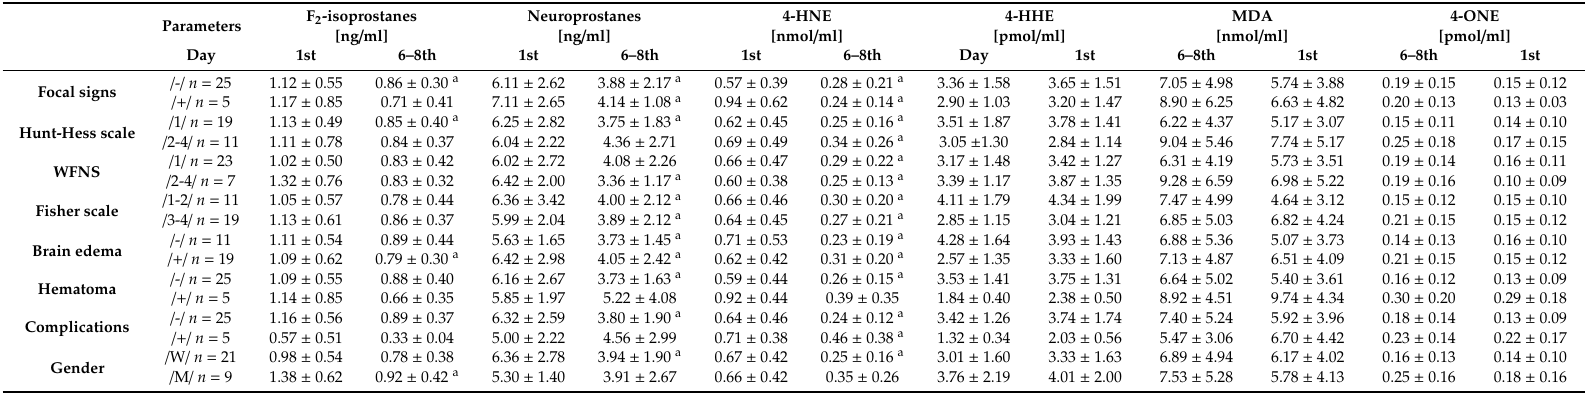
Table 2. The mean plasma concentration of lipid peroxidation products in SAH-patients with regard to neurological conditions and gender; a p < 0.05 in comparison with patients on the first day after